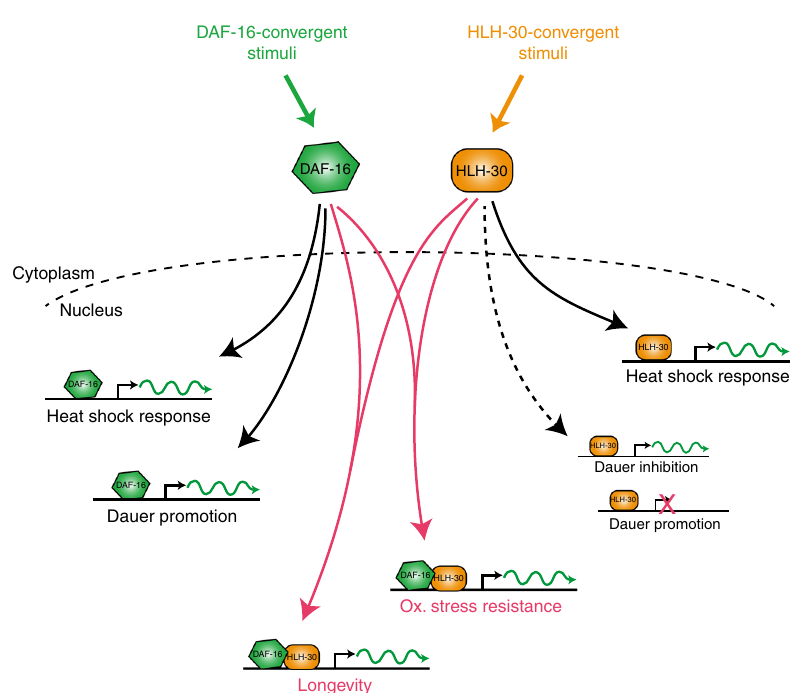
Fig. 8 Model. DAF-16 and HLH-30 form a sophisticated transcriptional regulatory module. Under non-stressed conditions, both transcription factors reside in the cytoplasm — away from their target genes. However, diverse harmful conditions, some of which converge more on DAF-16, some of which converge more on HLH-30, and some that converge on both, can activate these transcription factors and cause their translocation into the nucleus. Different upstream stimuli and thus different degrees of DAF-16 and/or HLH-30 activation eventually lead to stimulus-speci fi c combinatorial regulation of target genes in the nucleus: Whenever DAF-16 is active, this is suf fi cient to promote dauer formation and to drive expression of some heat stress response genes. On the other hand, active nuclear HLH-30 is suf fi cient to increase aspects of heat stress resistance and mildly impair dauer formation. However, a large set of target genes requires the combined action of both transcription factors, where the upstream stimuli must have suf fi ciently activated and translocated both, DAF-16 and HLH-30, allowing for their complex formation, joint binding to promoter regions, and transcriptional induction at genes that